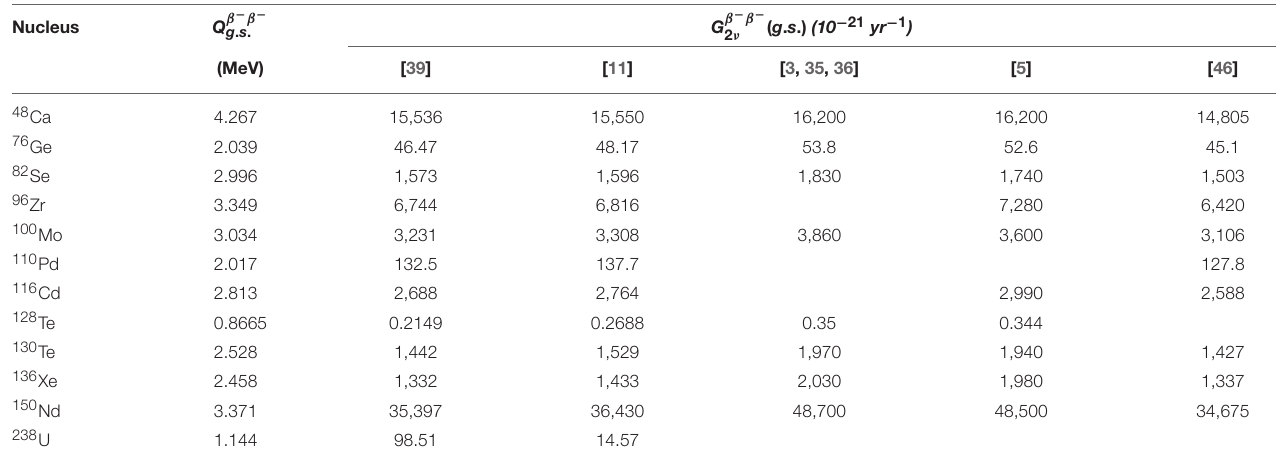
TABLE 1 | PSF for 2 νβ − β − decays to final